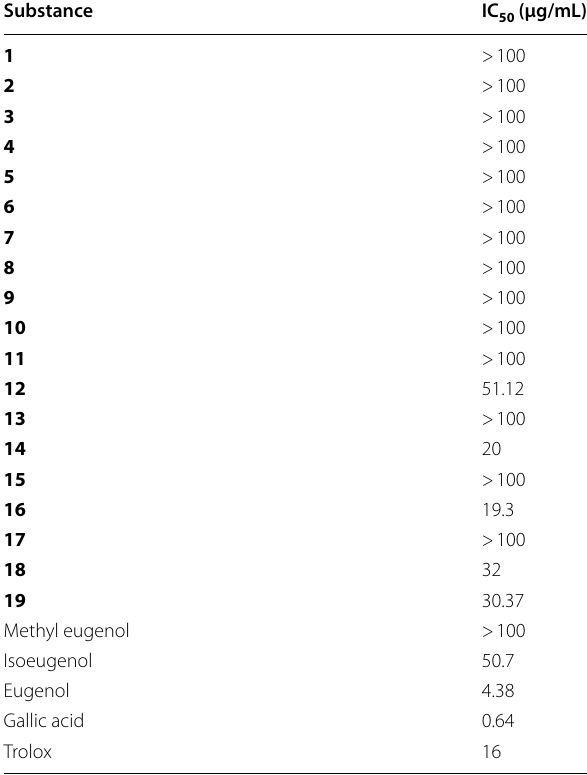
Table 3 Inhibitory concentration of 50% (IC radicals presented by the eugenol derivatives